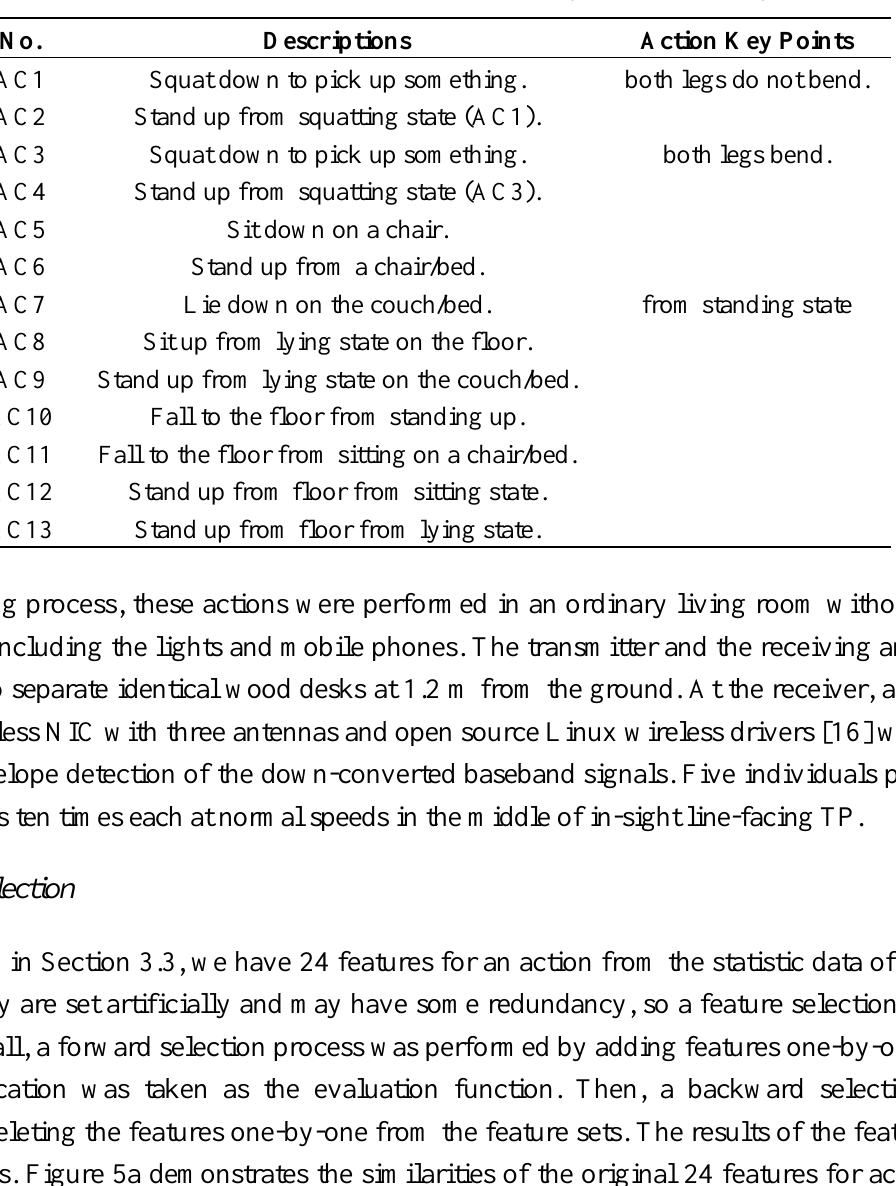
Table 1. Thirteen selected primitive full-body actions in daily